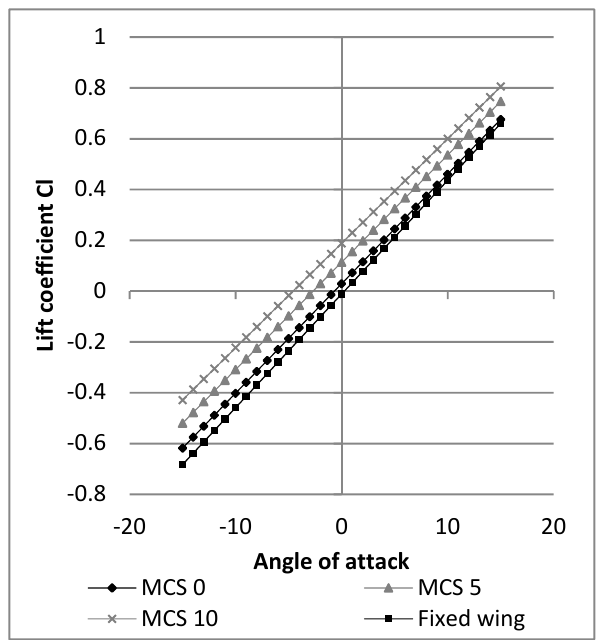
Figure 25. Lift coefficient variation with angle of attack for the UAS-S4 wing.